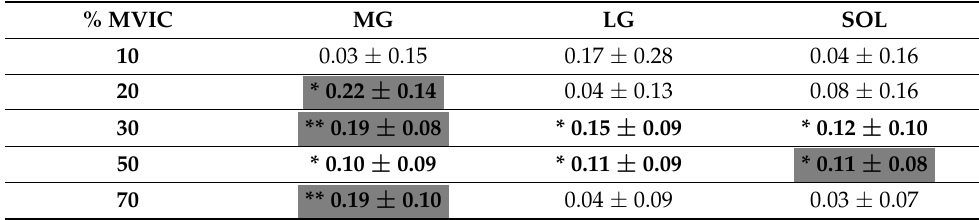
Table 4. Stepwise regression model to identify possible predictors of the relative variability for torque (T CoV ) out of the relative variabilities for EMG burst (MG CoV , LG CoV , and SOL CoV ) across the ankle joint angles at each contraction level. Data are shown as the estimated coefficient ± 95% confidence interval. The significant predictors are in boldface type and the most important variable is highlighted. * p < 0.05. ** p <